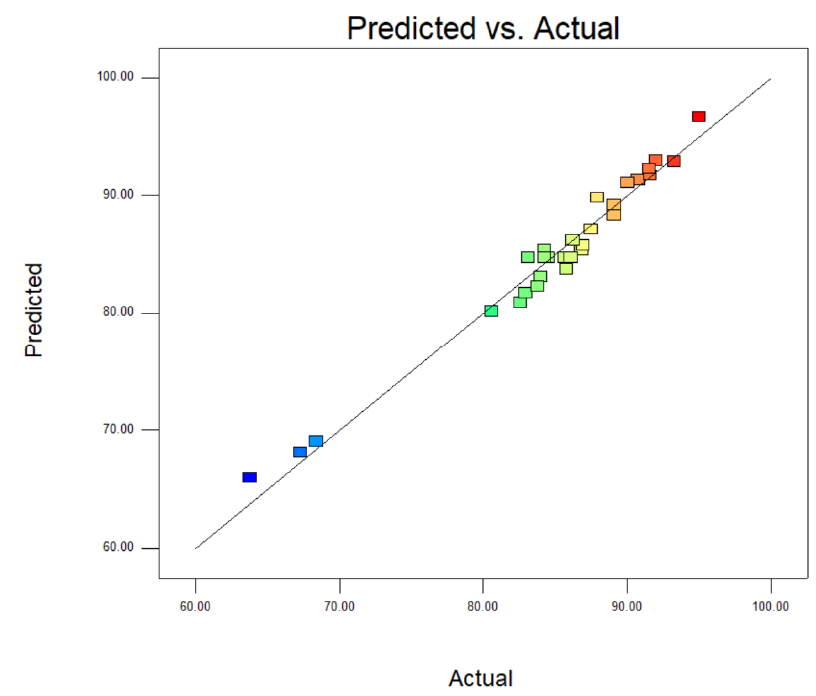
Figure 17. Comparison of predicted and actual values.